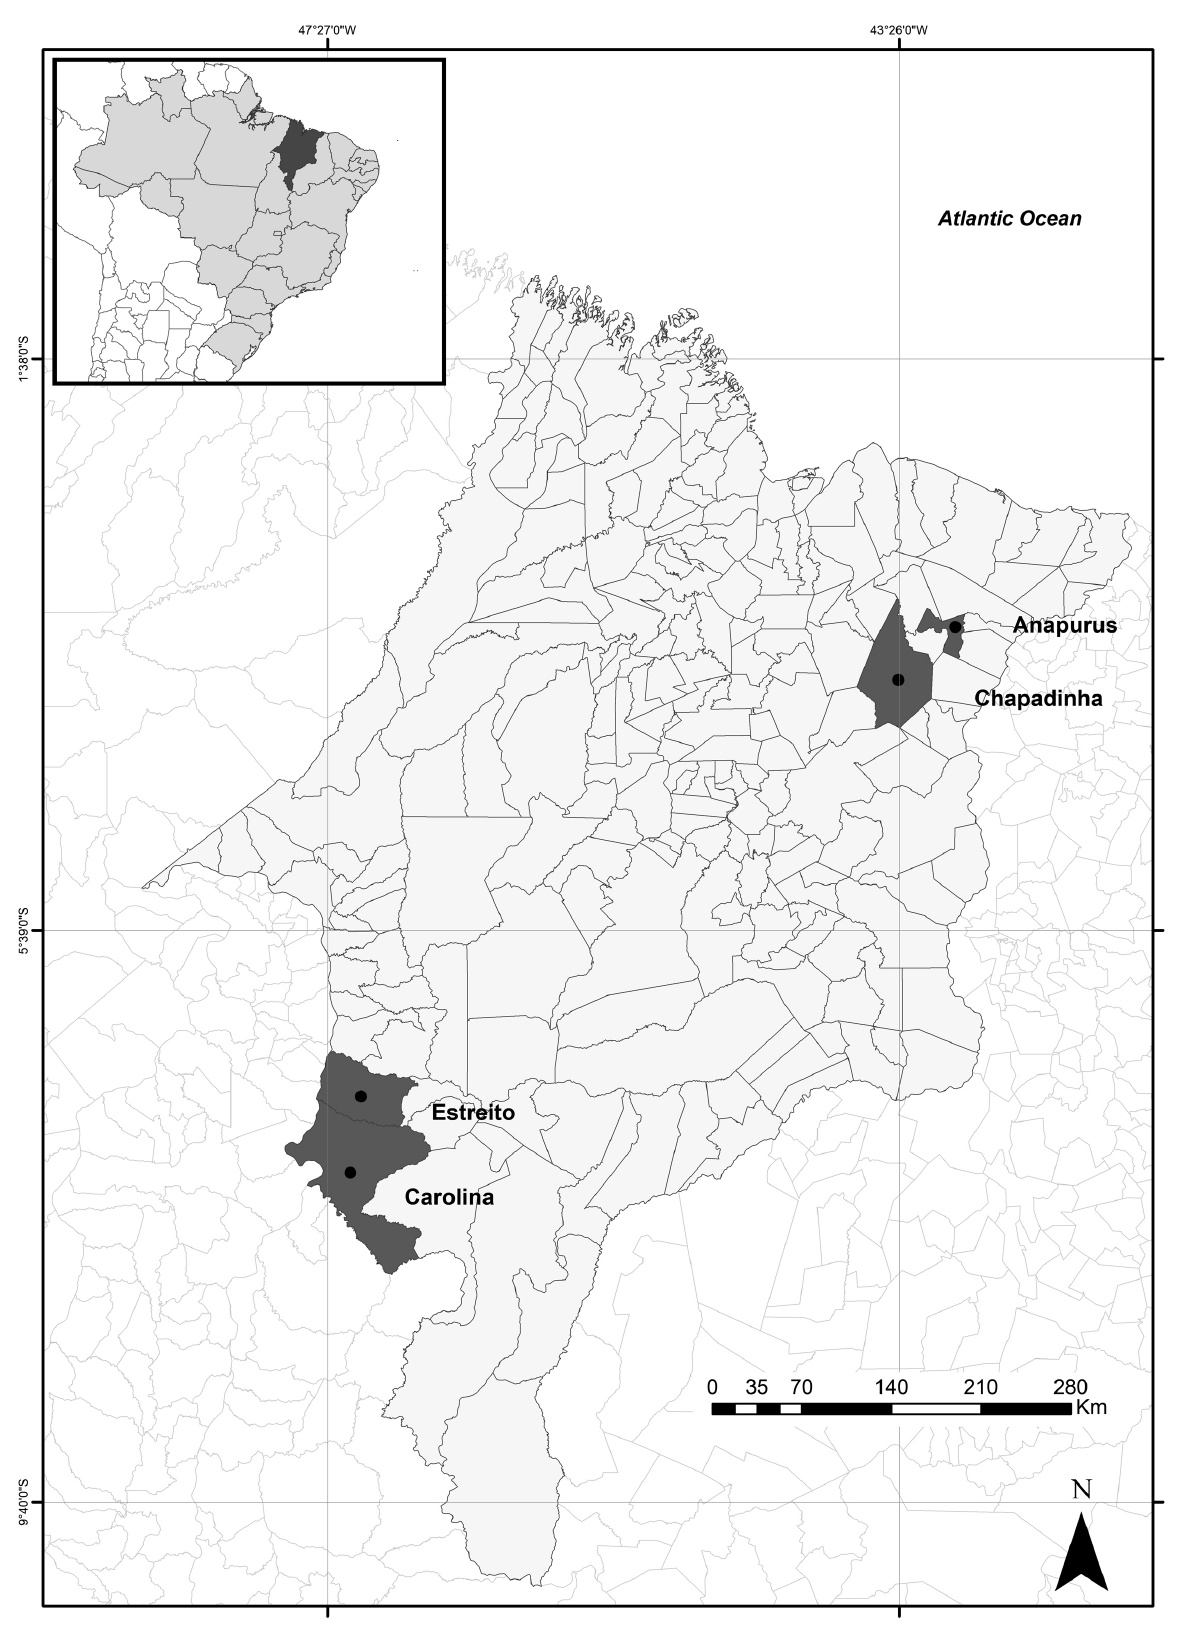
longitudinal hyaline strips. Spores subspherical, red- brown, ornamented, wingless, distal surface with 8–11 areolae, proximal face with incomplete areole, 60–100 µm